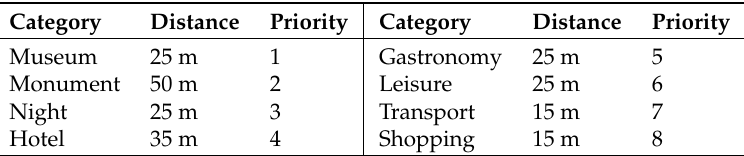
Table 4. Priorities and distances used in this case